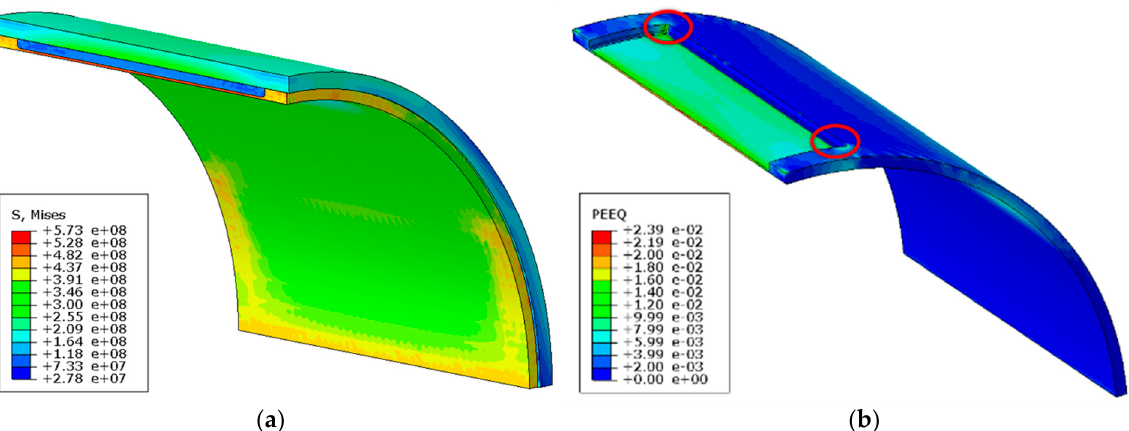
Appl. Sci. 2022 , 12 , x FOR PEER REVIEW Figure 15. ( a , b ) Von Mises stress [Pa] and equivalent plastic strain distributions for SM1; red circles in ( b ) to highlight the stress concentration positions.